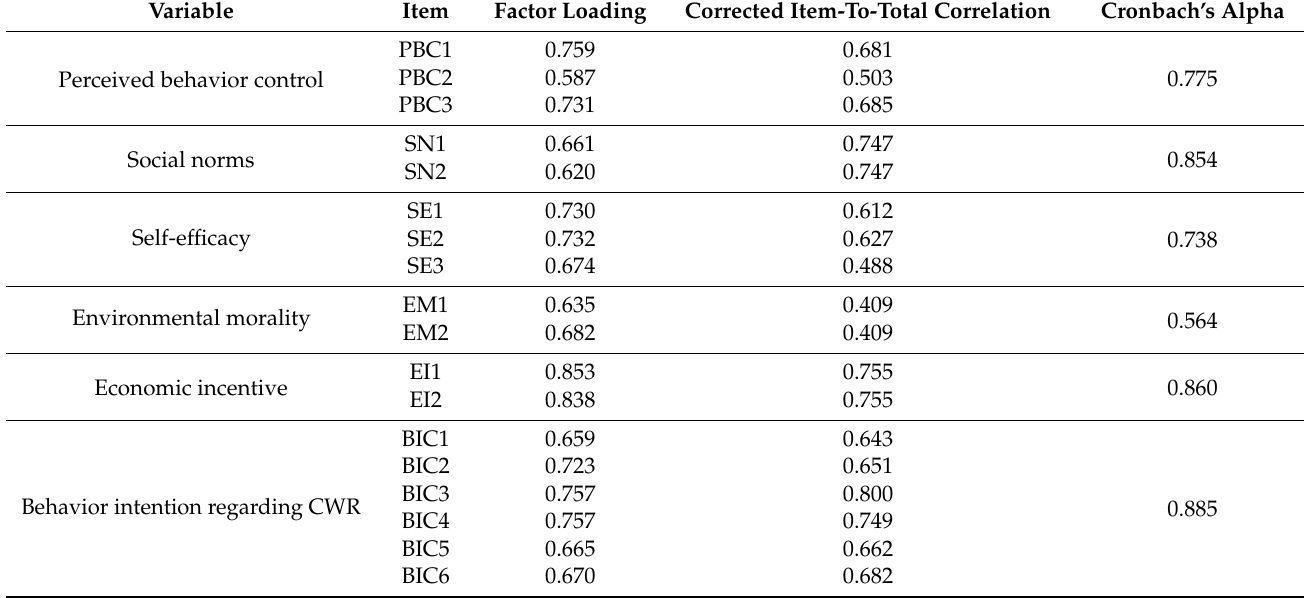
Table 4. Reliability of the